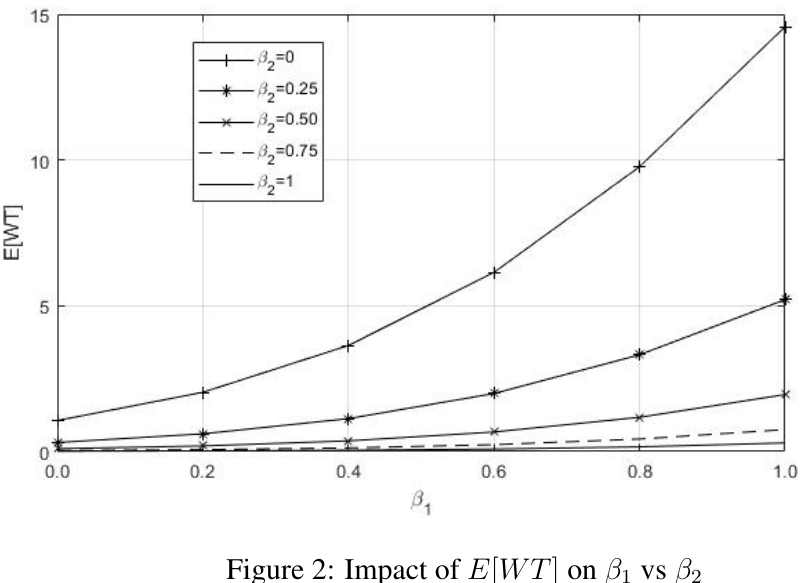
Figure 2: Impact of E [ W T ] on β